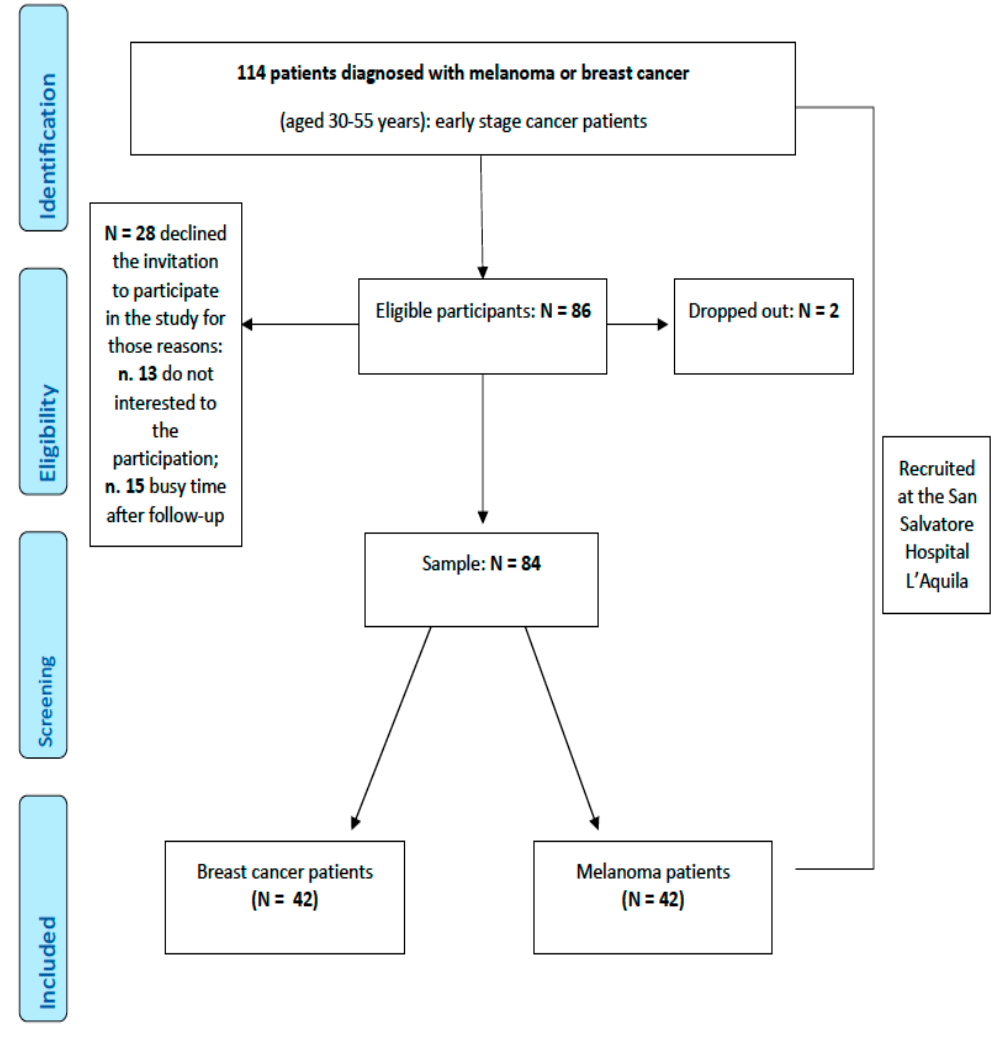
Figure 1. Flowchart of the participants.